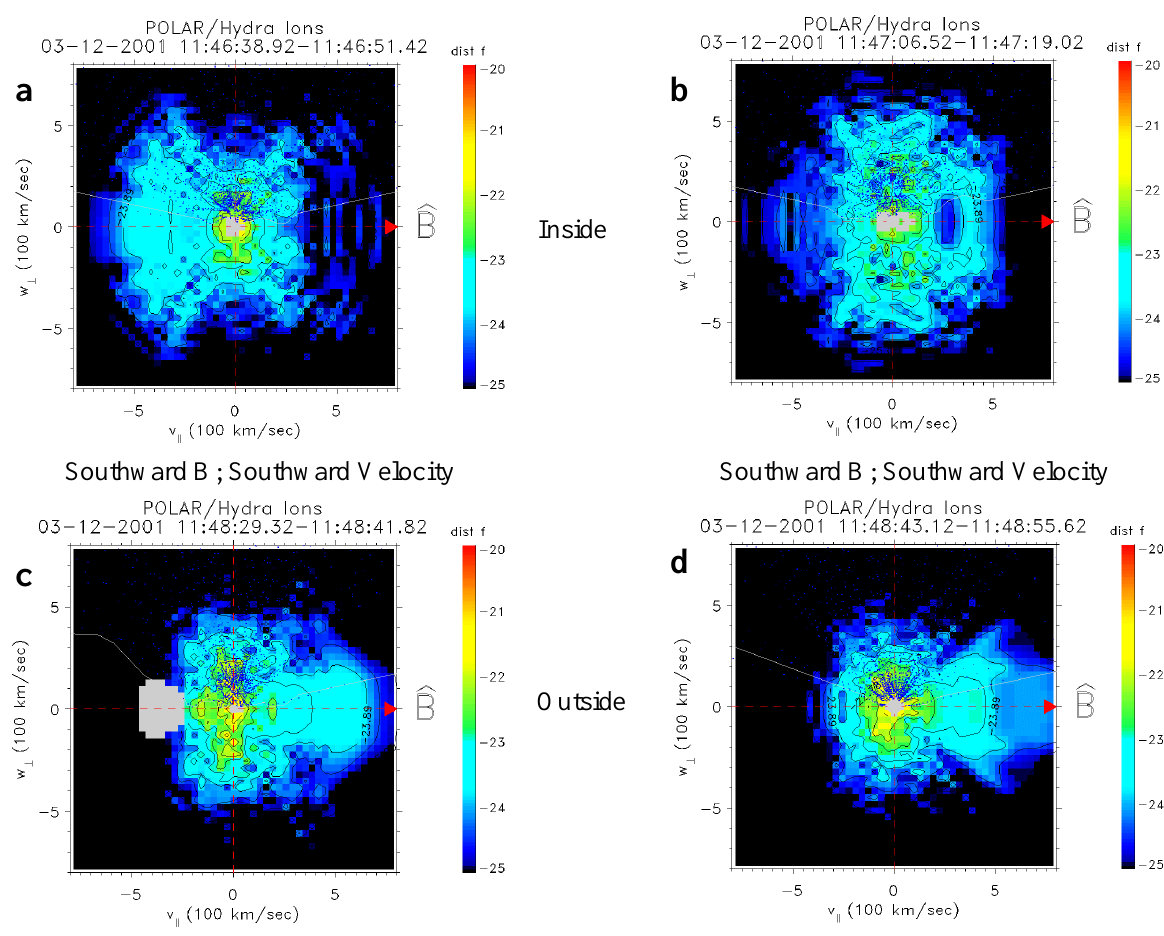
Fig. 8. Ion distribution plots for the magnetopause crossing interval indicated by the second circle in Fig.